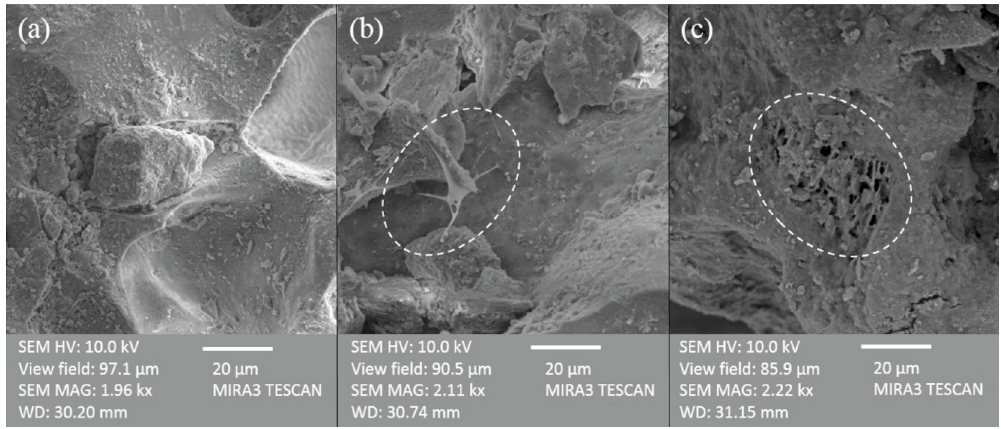
Figure 9. FE-SEM images of tezontle , ( a ) clean tezontle ; ( b ) tezontle after 4 weeks of exposition to wastewater; and, ( c ) tezontle after 24 weeks of exposition to wastewater.